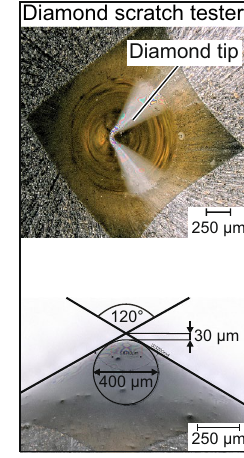
Fig. 1 Experimental setup of the scratch test